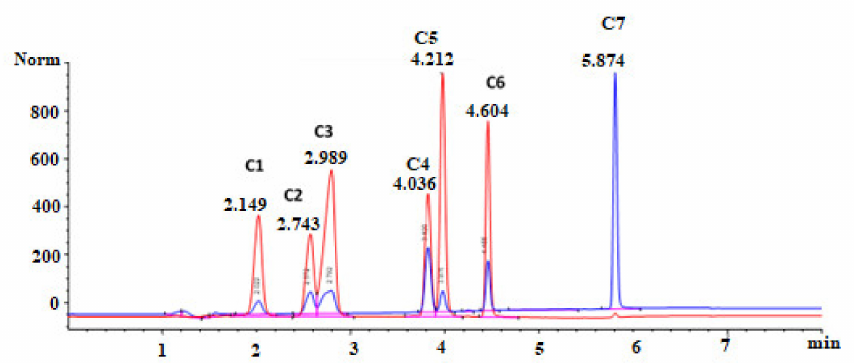
Figure 2. Separation of the C 1 -C 7 using a gradient elution mode commencing at 0 min 25% B, 2 min 40% B, 3 min 65% B, 4 min 100% B, with a run time of 6.5 min. Injection volume of 5 µ L, flow rate of 1 mL min − 1 , and temperature of 25 ◦ C, at λ = 254 nm (blue) and λ = 331.4 nm